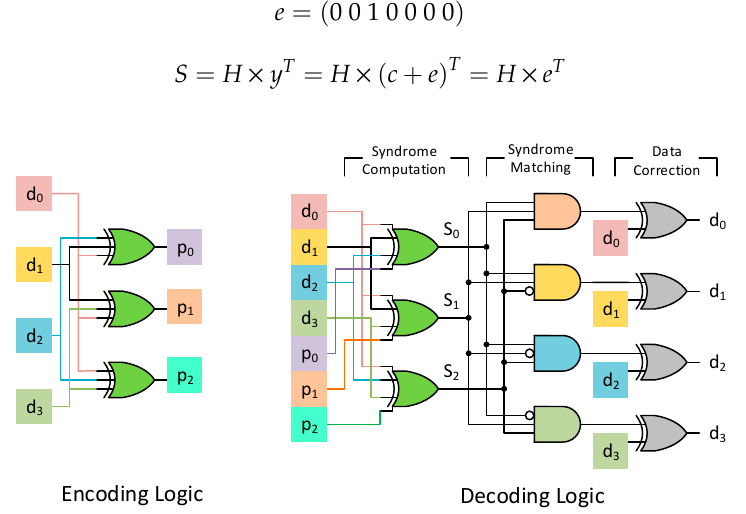
Figure 3. Encoding and decoding circuit of a (7, 4) Hamming code.